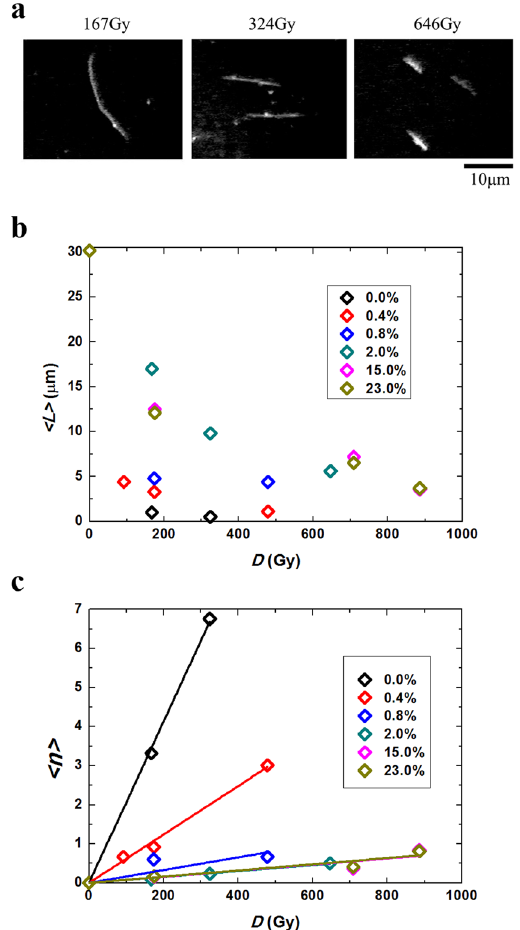
Figure 3. DSBs induced by γ -ray. ( a ) Fluorescence microscopic images of DNA molecules fixed on a glass surface after irradiation with different doses of γ -ray. ( b ) Average DNA lengths, 〈 L 〉 , vs. the irradiation dose of γ -rays. ( c ) Number of DSBs per 10 kbp, 〈 n 〉 , vs. the irradiation dose of γ -rays. (The kinetic constants, K γ ‘s (Gy), are evaluated from the slopes of Fig. 3c.) The slopes are essentially the same for the DMSO concentrations above 2%, indicating saturation